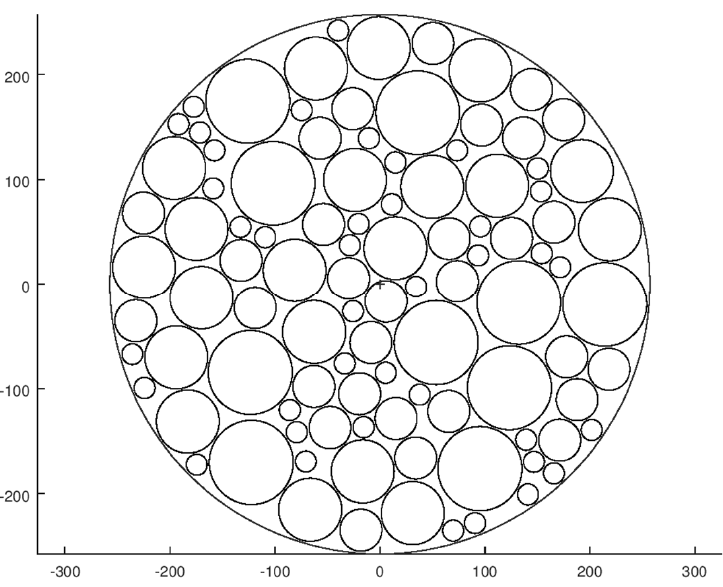
Figure 4. Placement of 100 circles for the sequential solution, r up = 257.35311 .